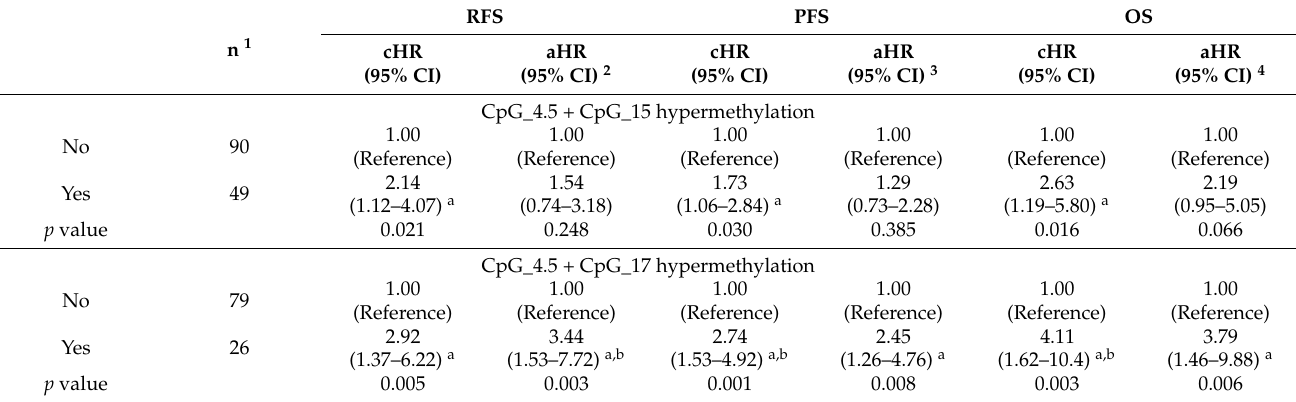
Table 5. Impact of different combinations of CpG4.5, CpG15, and CpG17 of PTGER4 hypermethyla- tion in tumor tissue on 5-year